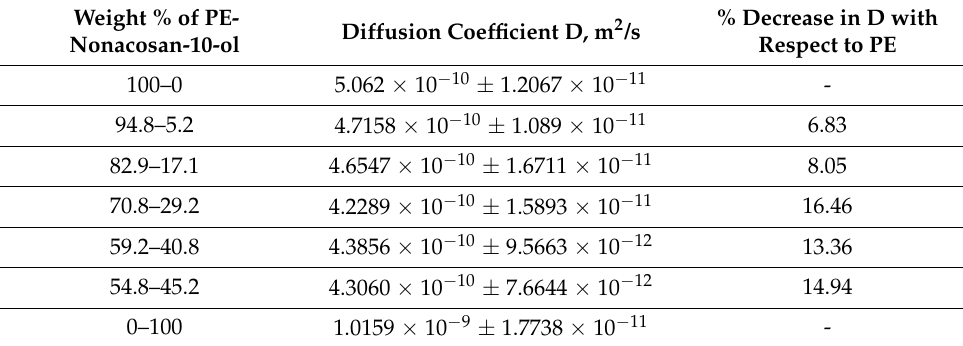
Table 1. Diffusion coefficient of oxygen from MD